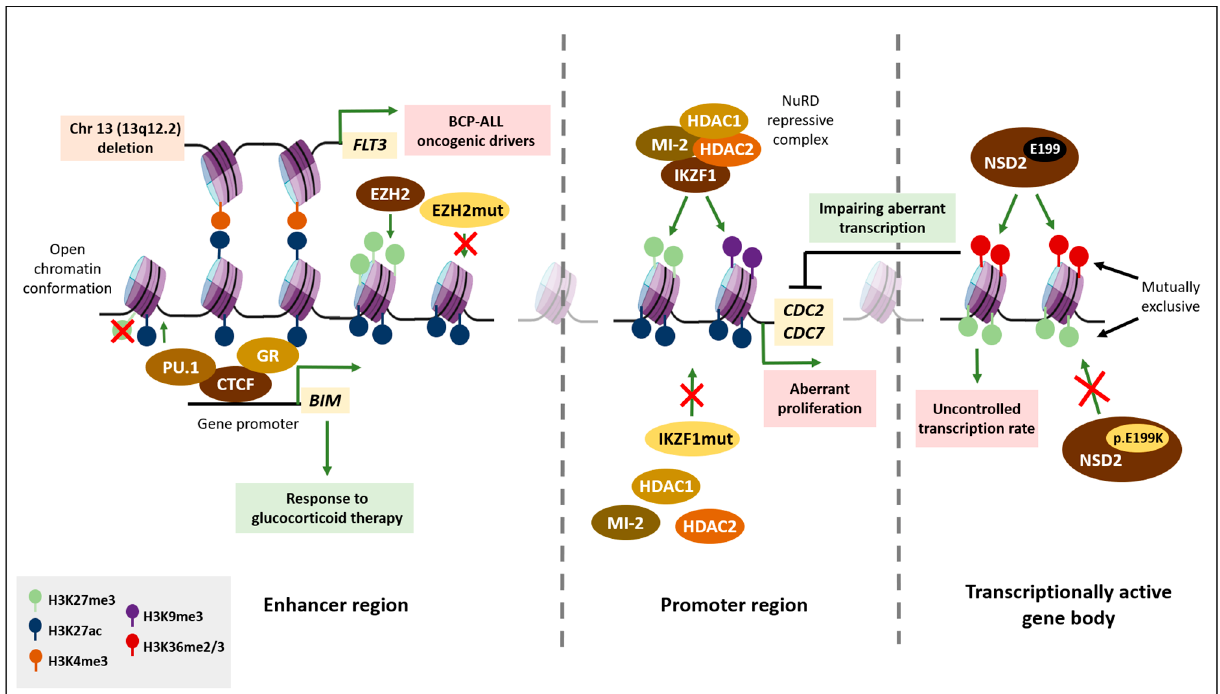
Figure 1. Dual effects of epigenetic regulation of H3K27 in BCP-ALL. Schematic picture of how epigenetic alterations of the H3K27 residue affect gene regulation and key biological processes that guide the progression of BCP-ALL. Green arrows indicate activation; red lines and crosses indicate repression. Black line indicates control of uncontrolled transcription rate. Green squares indicate biological processes that improve BCP-ALL outcome; red squares indicate processes that induce poorer prognosis. Distinct colors have been assigned to each histone modification mark, as indicated in the Figure Legend.